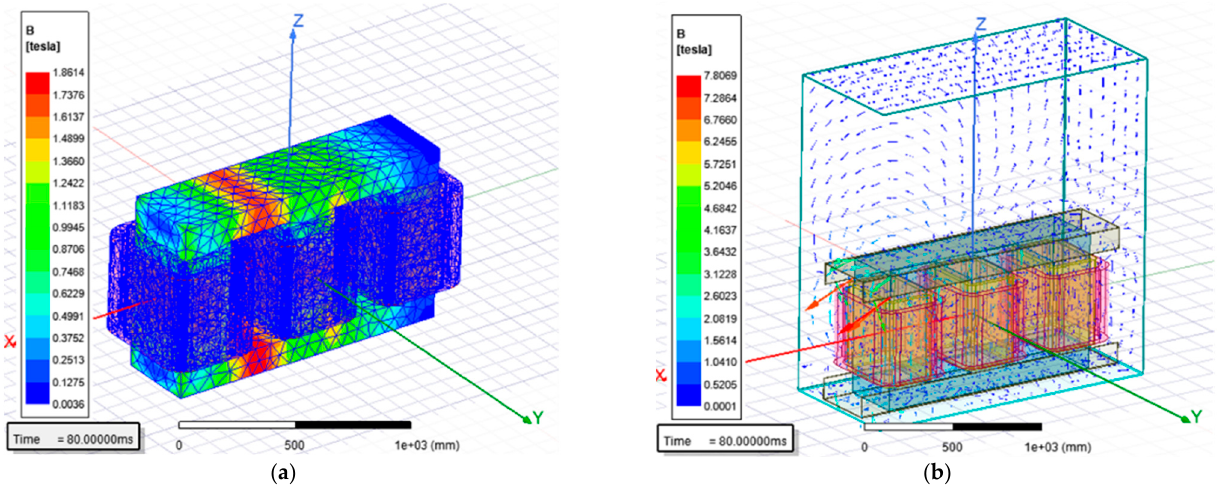
Figure 9. Flux density simulation of harmonic profile design transformer: ( a ) core; ( b ) tank. As shown in Figure 10, the total losses (CoreLoss), eddy current losses, and hysteresis losses are calculated. The total loss calculation had a maximum value of 1.12 kW. Figure 10. Core losses of harmonic profile design transformer. The data results obtained in FEM simulation were compared between the standard design and harmonic profile design to obtain a percentage change, as shown in Figure 11. The results show a similarity with the results using the manufacturer’s design software in Figures 3 and 4, where an increase in magnetic flux density and loss is noticed, mainly in the core losses. It should be noted that the increase in total losses in the FEM analysis is 4.72% (close to 5.04% when using manufacturer’s design system tool calculations shown in Figure 3) and is an indication that the design will meet the required efficiency even with the harmonic profile considered. Additionally, in Figure 11, the FEM simulation results show an increase in the percentage of flux and are similar to the value calculated by the manufacturer’s design system tool in Figure 3. However, the increase in the flux density in the core, calculated in both cases, could be dangerous for the core’s material type. This may be an indication that other considerations in the design such as the electrostatic shielding could be required. These results evidence the requirement of analyzing different types of core material for